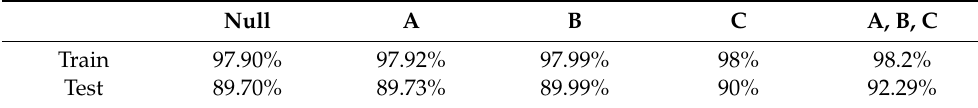
Figure 10. Statistical chart of a priori information. Table 3. A priori information on the model